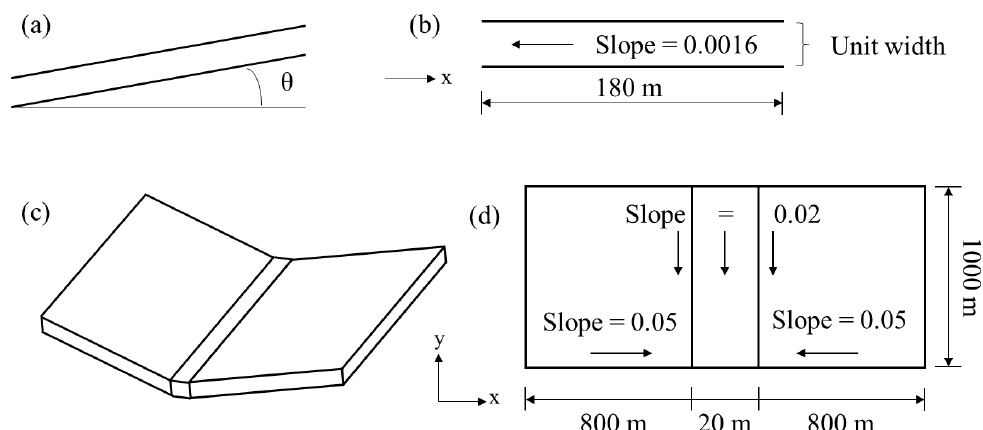
Figure 3. Computational domains of the 1D parking lot case and 2D V-catchment case: ( a ) Schematic description of the parking lot; ( b ) 1D view of the parking lot; ( c ) Schematic description of the V-catchment area; ( d ) 2D view of the V-catchment.